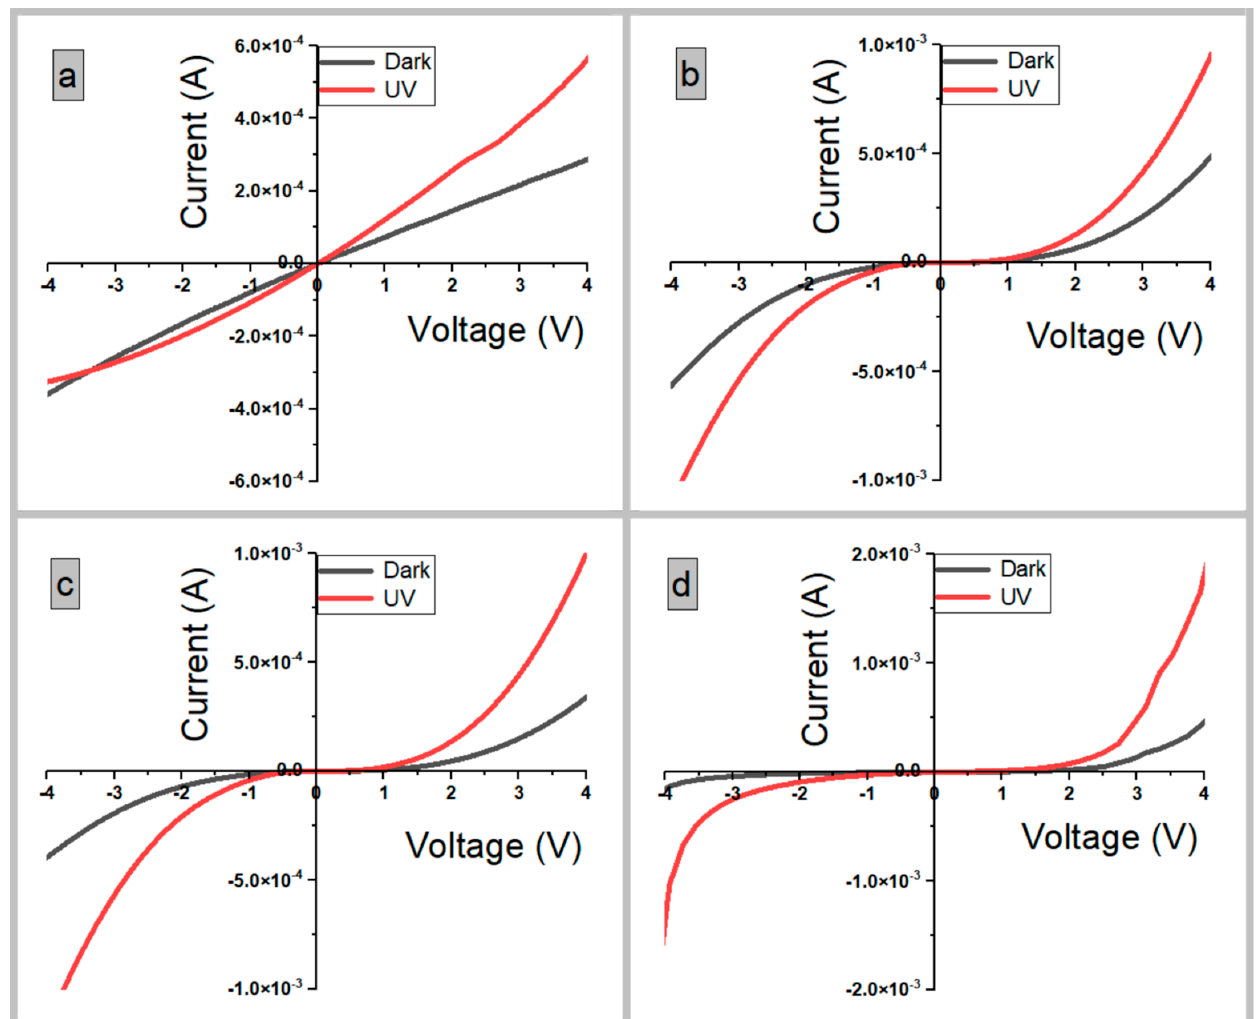
Figure 9. I − V curves for photodetector devices S 1 , S 2 , S 3 , and S 4 under dark and UV illumination (365 nm, 2.83 mW/cm 2 ) at applied bias voltage from -4 V to +4 V. ( a ) S 1 , ( b ) S 2 , ( c ) S 3 , and ( d ) S 4.